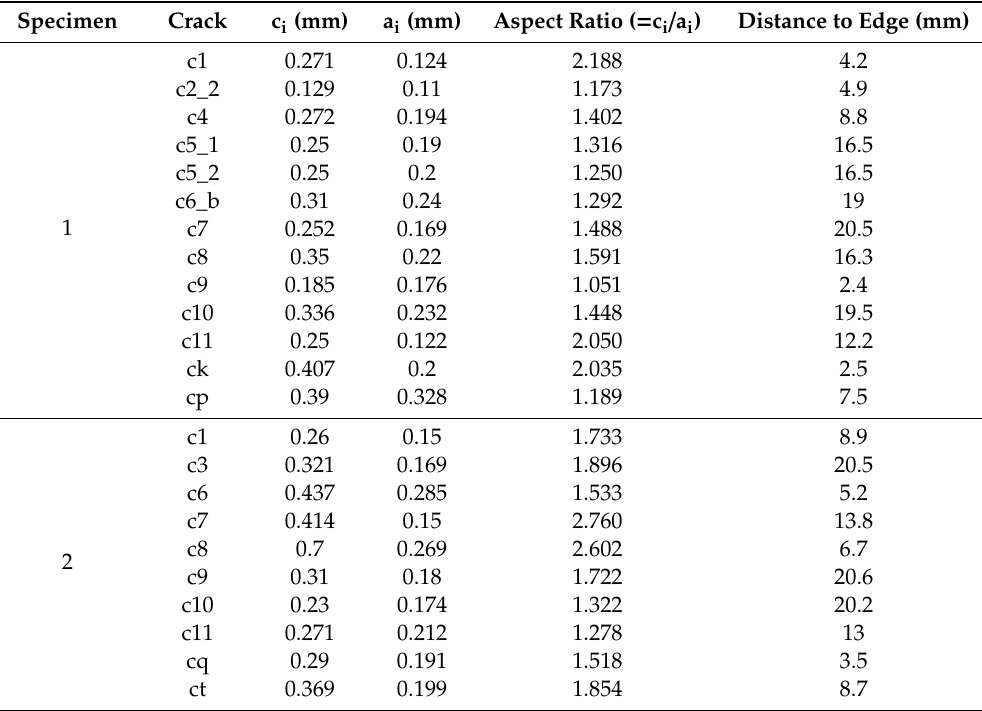
Table 2. Details of the twenty three surface material defects in Specimens 1 and 2.